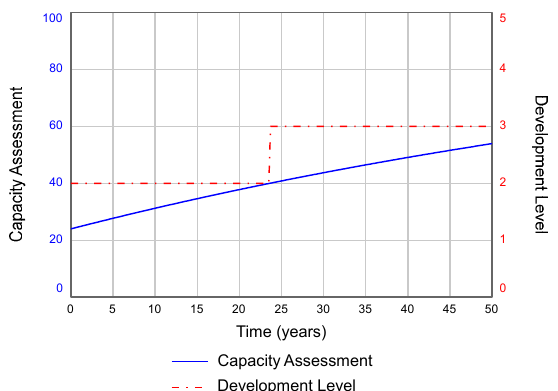
Figure 8. Variation of community capacity assessment and community development with time. No capacity dependency is assumed.